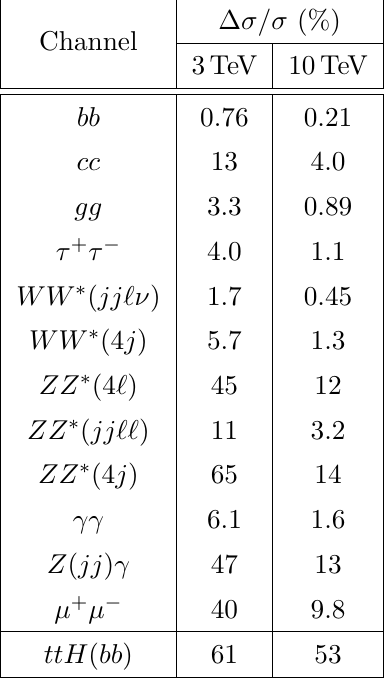
Table 9 . Signal precision for selected Higgs production channels at 3 TeV and 10 TeV muon colliders using Delphes fast simulation including physics backgrounds. All channels are for the combined W + W − fusion and ZZ fusion processes. t ¯ tH includes all of s -channel, ZZ fusion, and W + W − fusion production